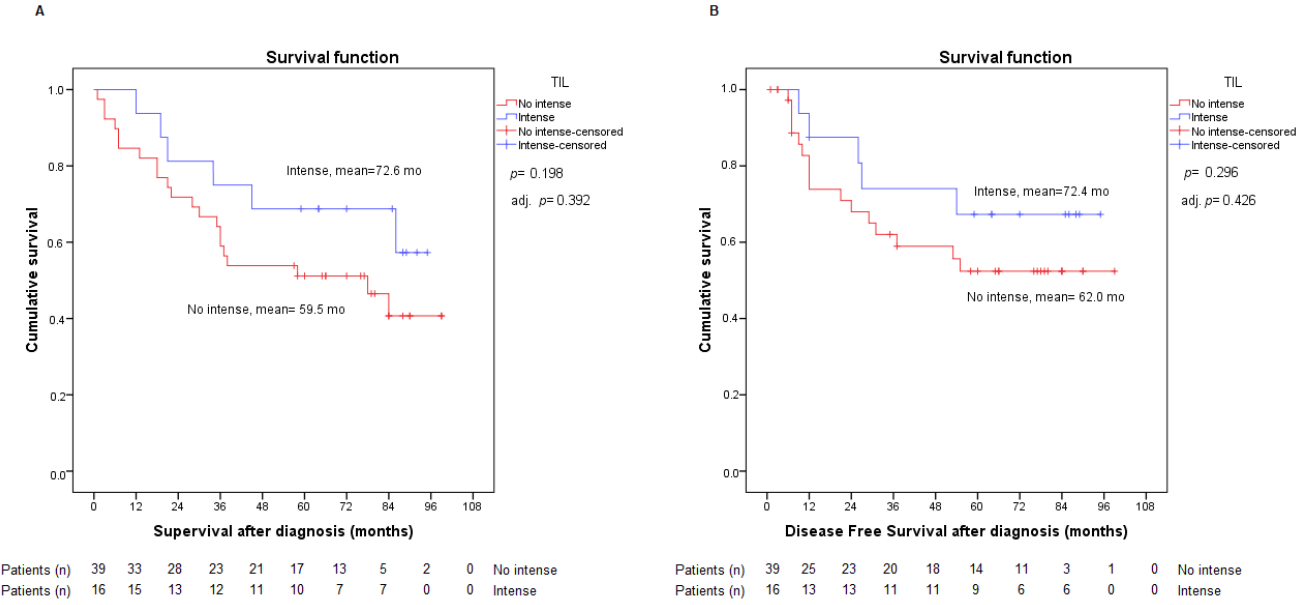
Figure 2. Analysis of overall survival ( A ) and disease-free survival ( B ) according to PD-L1 expression <1% or ≥ 1%. Adj. p : p -value from Cox regression model adjusted by stage.